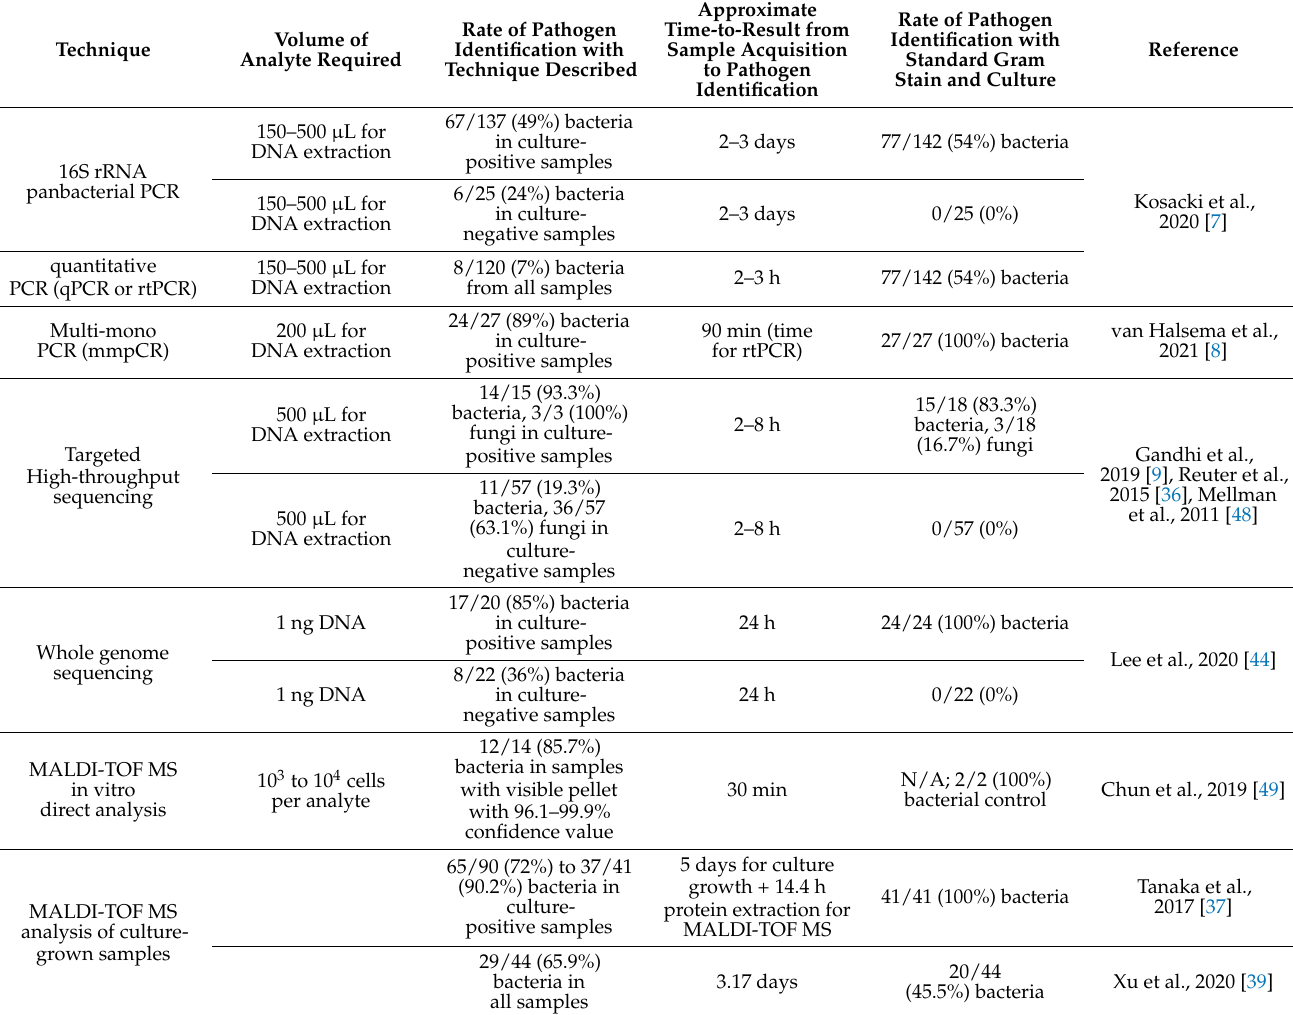
Table 1. Summary of microbiological techniques for pathogen identification in